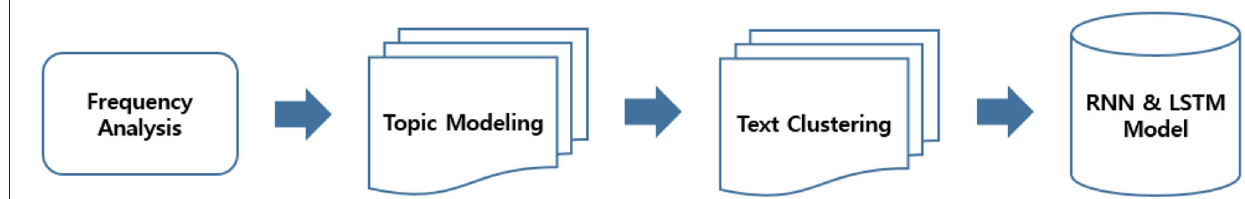
FIGURE 1 | Flowchart of the study.